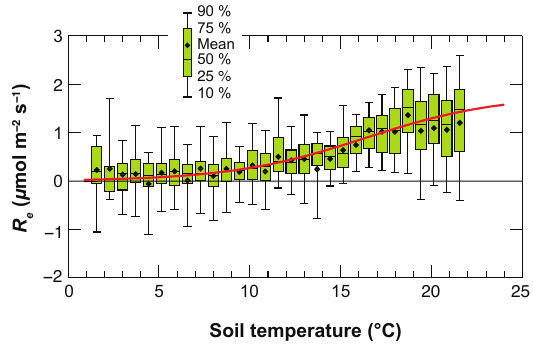
Figure 6. Annual light-response curve determined from the daytime 30min NEE measurements and Eq. (1), i.e. GEP = R e +− NEE. The curves are the best fit of the Eq. (2). PPFD was binned for 30 classes from 0 to 1500µmolm − 2 s − 1 . Annual MQY was 4.00mmolCmol − 1 photons, P M was 4.68µmolm − 2 s − 1 , and C v was 0.7